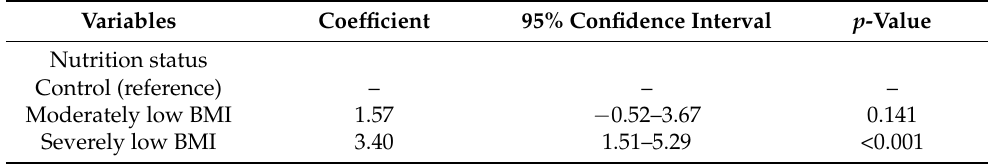
Table 4. Linear regression analyses for the length of hospital stay in survival cases.